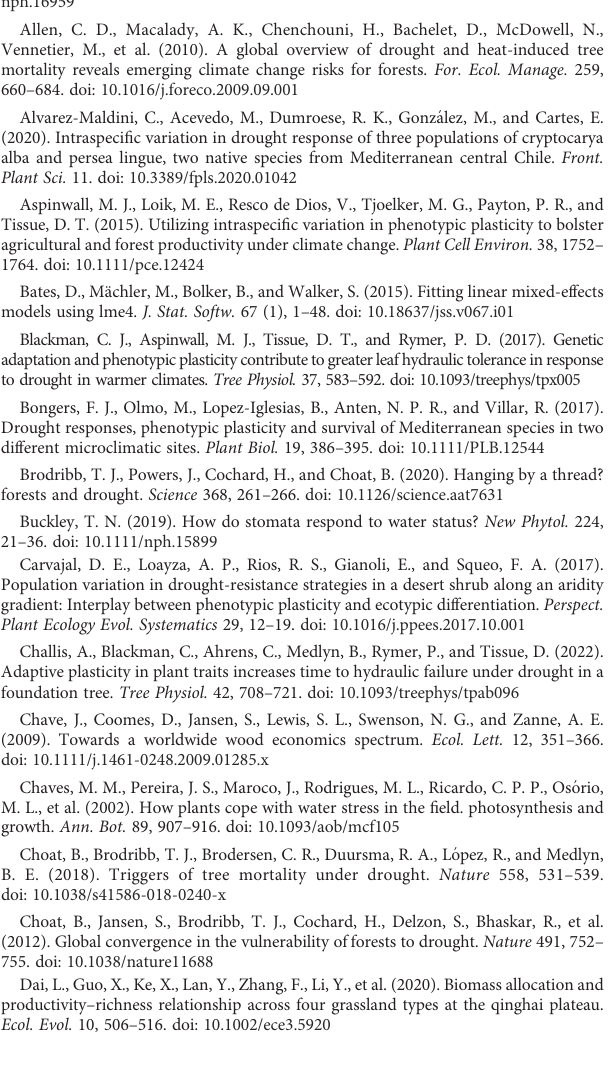
SUPPLEMENTARY TABLE 1 Natural occurring populations of B. marginata , with their locations and climate-origin selected for the study. LAT, latitude; LONG, longitude; MAT, mean annual temperature; MAP, mean annual precipitation; PWQ, precipitation of the warmest quarter.